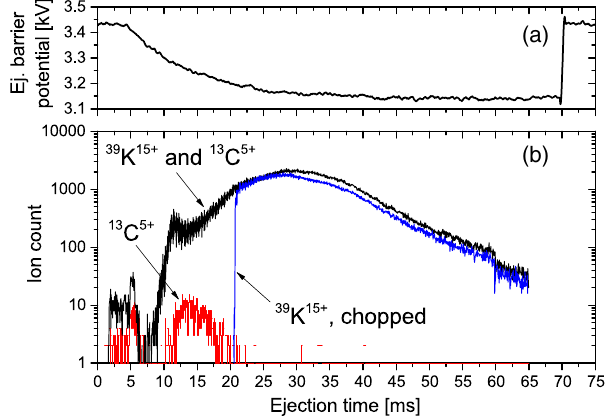
FIG. 16. (a) Exponential voltage ramp function for ion ejection, and (b) ion time distribution of ejected 13 C 5 þ and 39 K 15 þ accelerated to several MeV/u, delivered to a nuclear-physics experiment, and measured with an MCP. The “ chopped ” 39 K 15 þ time distribution was purified by delaying the on-time of the RFQ to prevent acceleration of 13 C 5 þ